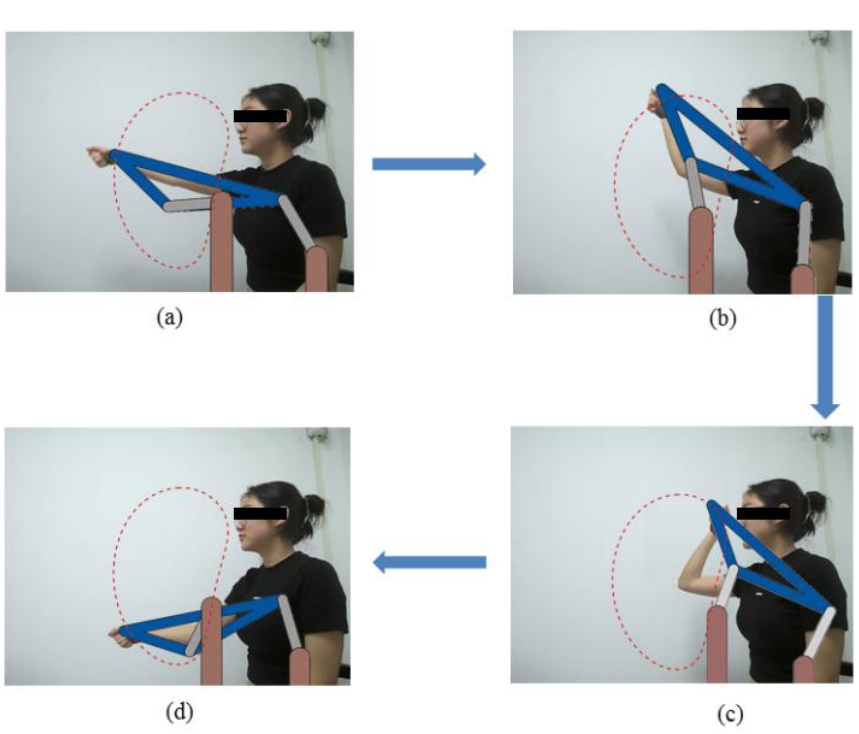
Figure 14. Wrist circle training motion with the fifth mechanism in Fig.